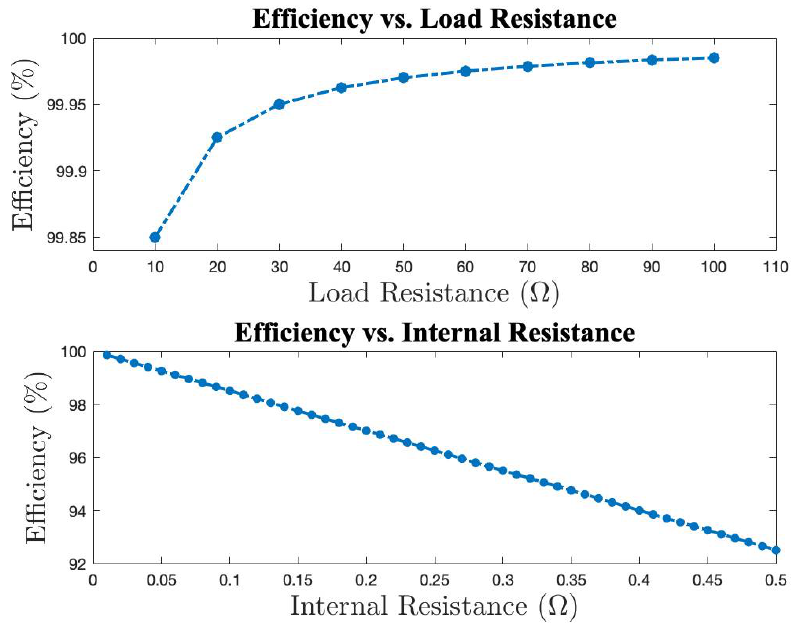
Figure 11. Efficiency of the lattice converter shown in Figure 8 increasing with a slowing rate as load resistance increases and decreasing linearly as internal resistance increases.